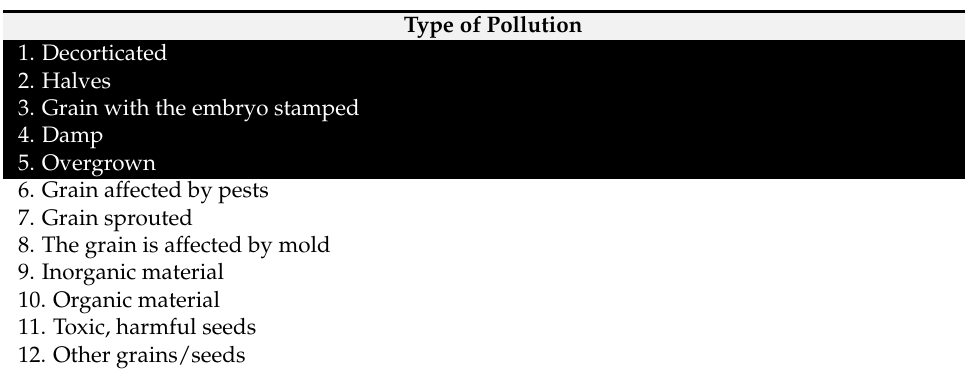
Figure 3. Screenshots of selected windows of the “ Hordeum v. 3.2” IT system. The analyses distinguished 12 types of imperfection (Table 2) features. The analysis aimed to obtain a precise description of the impurity groups of barley kernels, which were then defined by appropriate characteristic parameters. The most common groups of imperfections occurring in a given batch of barley during the production process in malt houses were considered. Table 2. Types of pollutants included in the “Hordeum 3.2” IT system. The blackgroud is the copyright shaders.